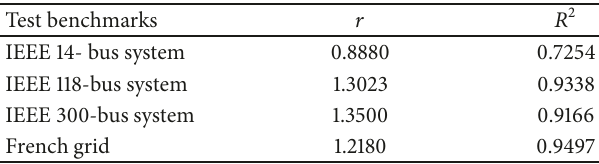
Table 2: Parameters 𝑟 and 𝑅 2 of cumulative distributions of the vertex degree in three CGs. Generally, 𝑅 2 ≥ 80 % has a satisfactory fitting